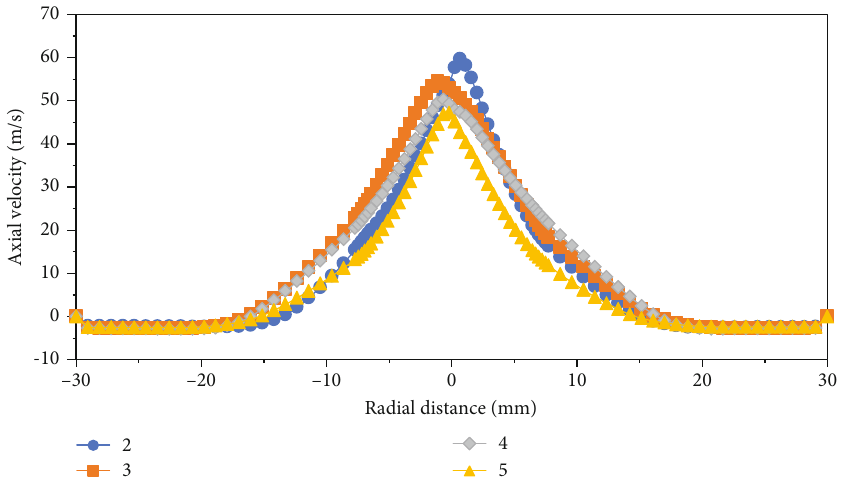
Figure 17: Axial velocity distribution of di ff erent blade thicknesses in h / d = 8 .